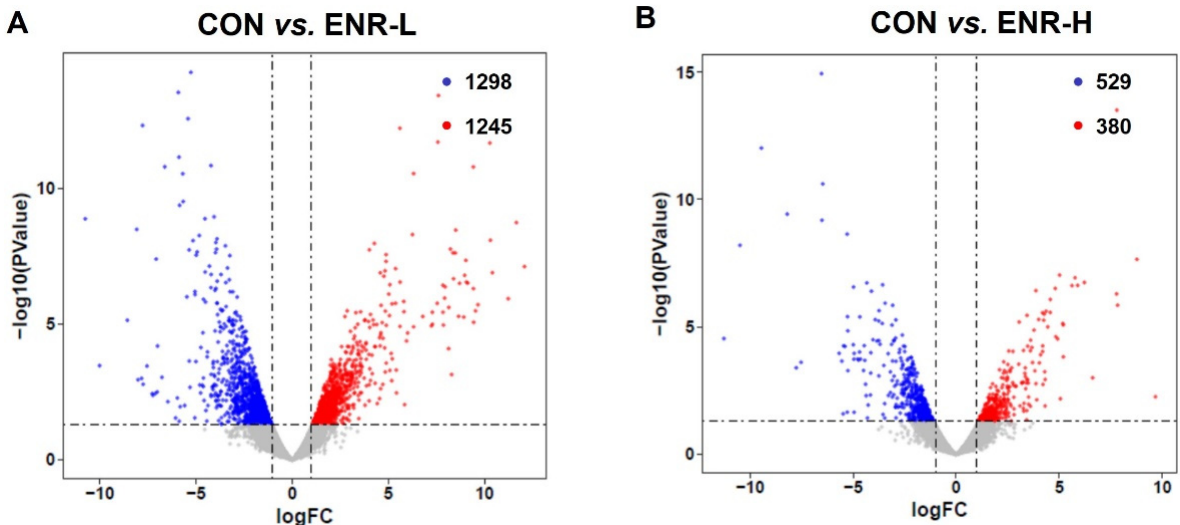
Figure 2. Volcano plot of the differences in the expression profiles of E. sinensis samples in the control and residue groups, respectively. CON represents control, ( A ) ENR-L represents low-concentration enrofloxacin residue group, and ( B ) ENR-H represents high-concentration enrofloxacin residue group. The x-axis represents logFC (fold change), while the y-axis represents − log10 ( p -value). Red represents significantly upregulated genes, blue represents significantly downregulated genes, and each circle represents a single gene.